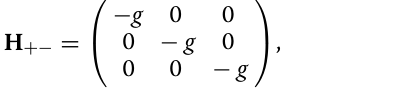
Fig. 3 The spectrum of the system with α = �/� 0 . a and b are for E 0 (in units of t ). Eigenvalues E k vs k y for magnetic flux ratio α = 1 / 3 , β = 0.2 π , a = 1 , and W = 9 are shown in c and d . The parameters are a k T = 0 and g / t = 0 , b k T = 0.84 and g / t = 0.5 , c k T = 0 and g / t = 0 , and d k T = 0.84 and g / t =